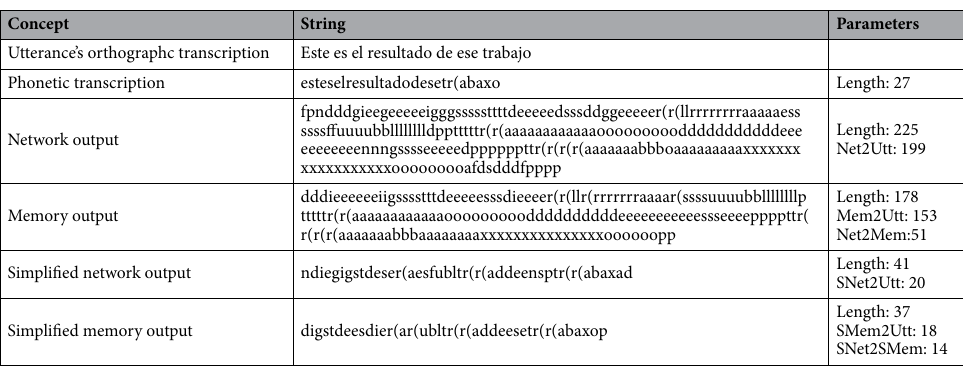
Concept String Parameters Utterance’s orthographc